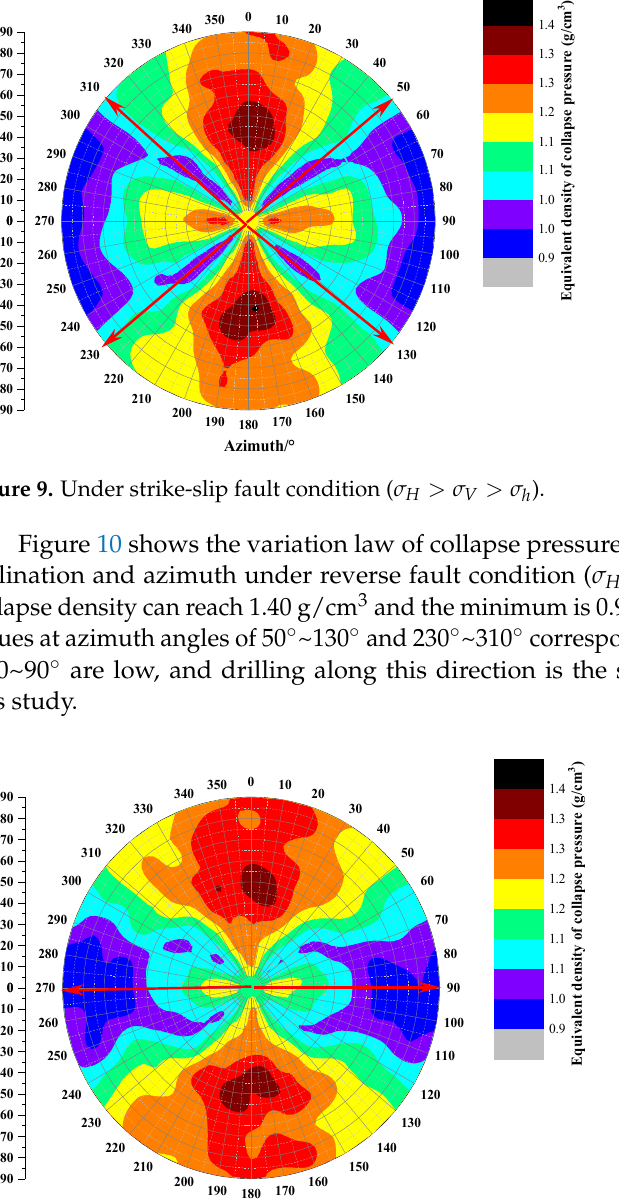
170180190200210220230240250260270280290300310 σ σ σ> > Figure 10. Under reverse fault condition ( σ H > σ h > σ V Figure 10. Under reverse fault condition ( H h V ). σ σ σ> > Figure 10. Under reverse fault condition ( H h V ). The analysis shows that no matter under which in situ stress mechanism, the well- bore in the vertical well section is the most stable, and when the inclination angle is ap-